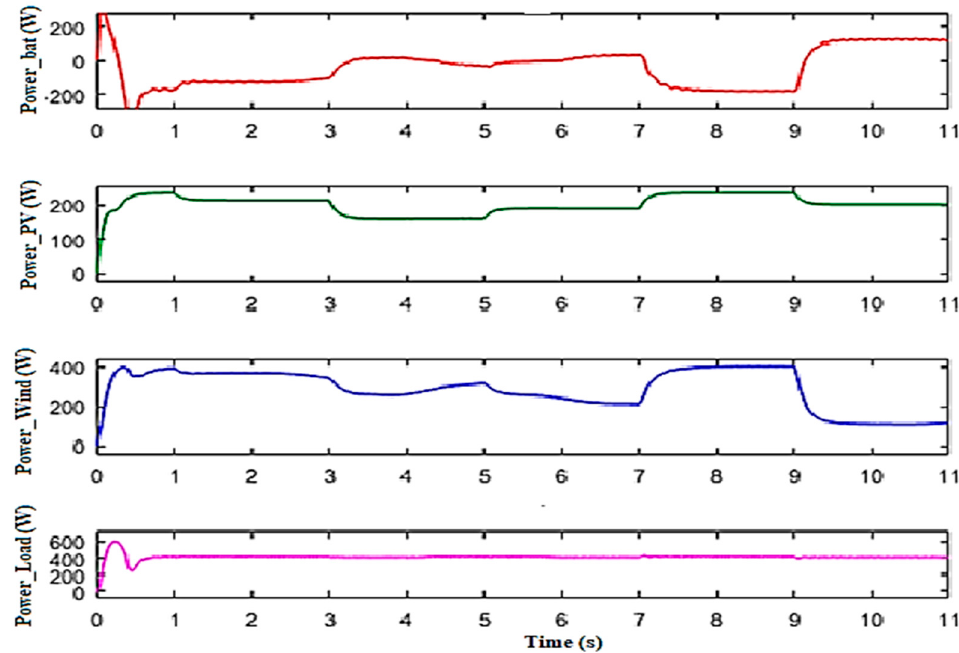
Figure 12. Output power profiles generated by the different sources and the DC bus.